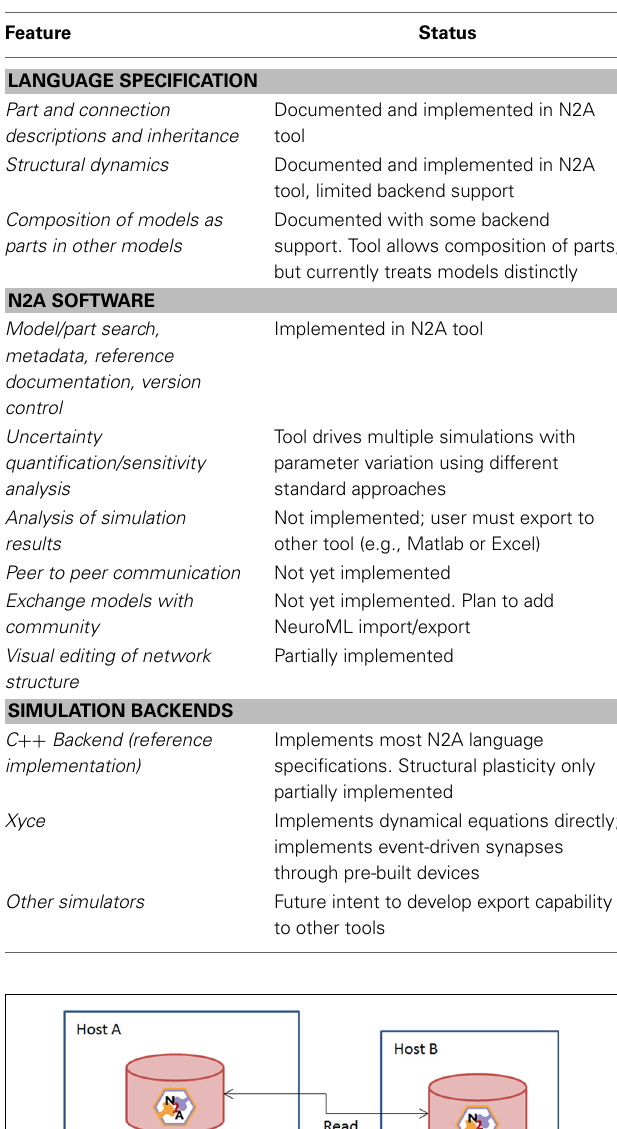
Table 2 | Status of current and future features of N2A.